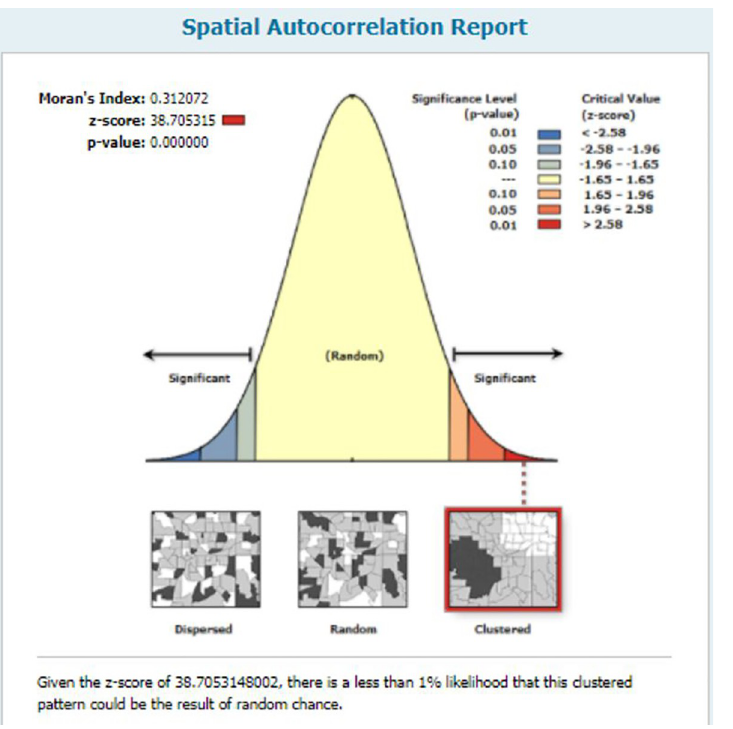
Fig 2. Spatial autocorrelation of modern contractive use in Nigeria,